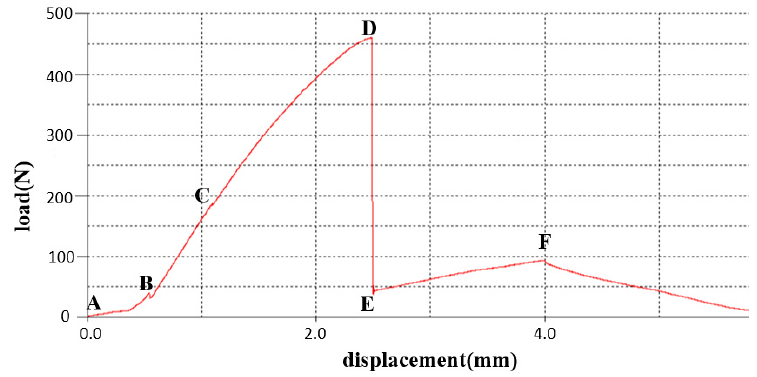
Figure 7. Force—displacement curve of the walnut shell breaking under load.